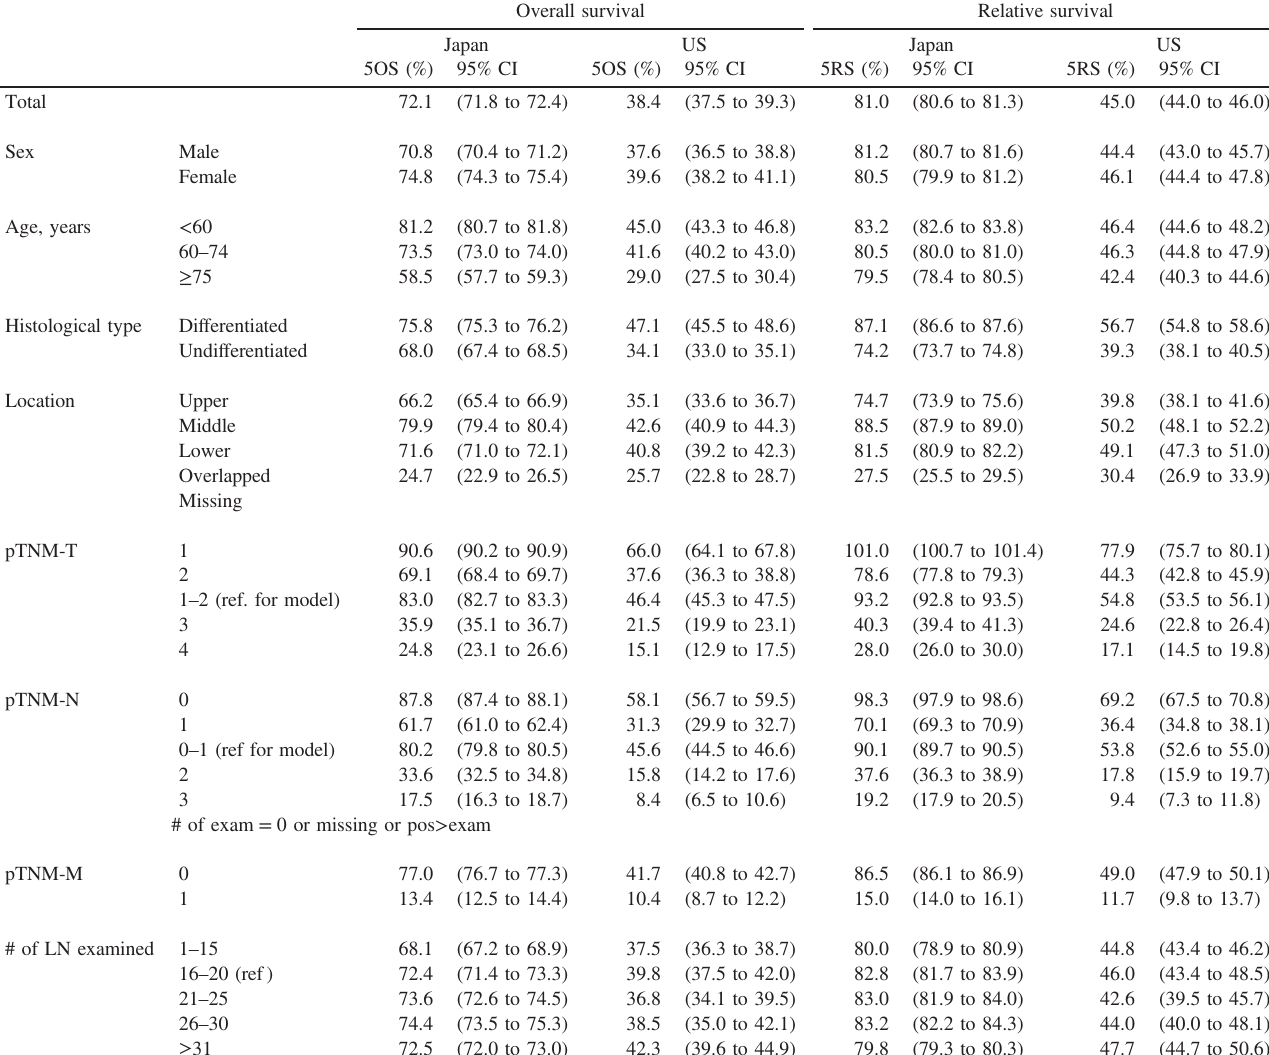
Table 2. Five-year overall survival (5OS) and relative survival (5RS) by prognostic factors and